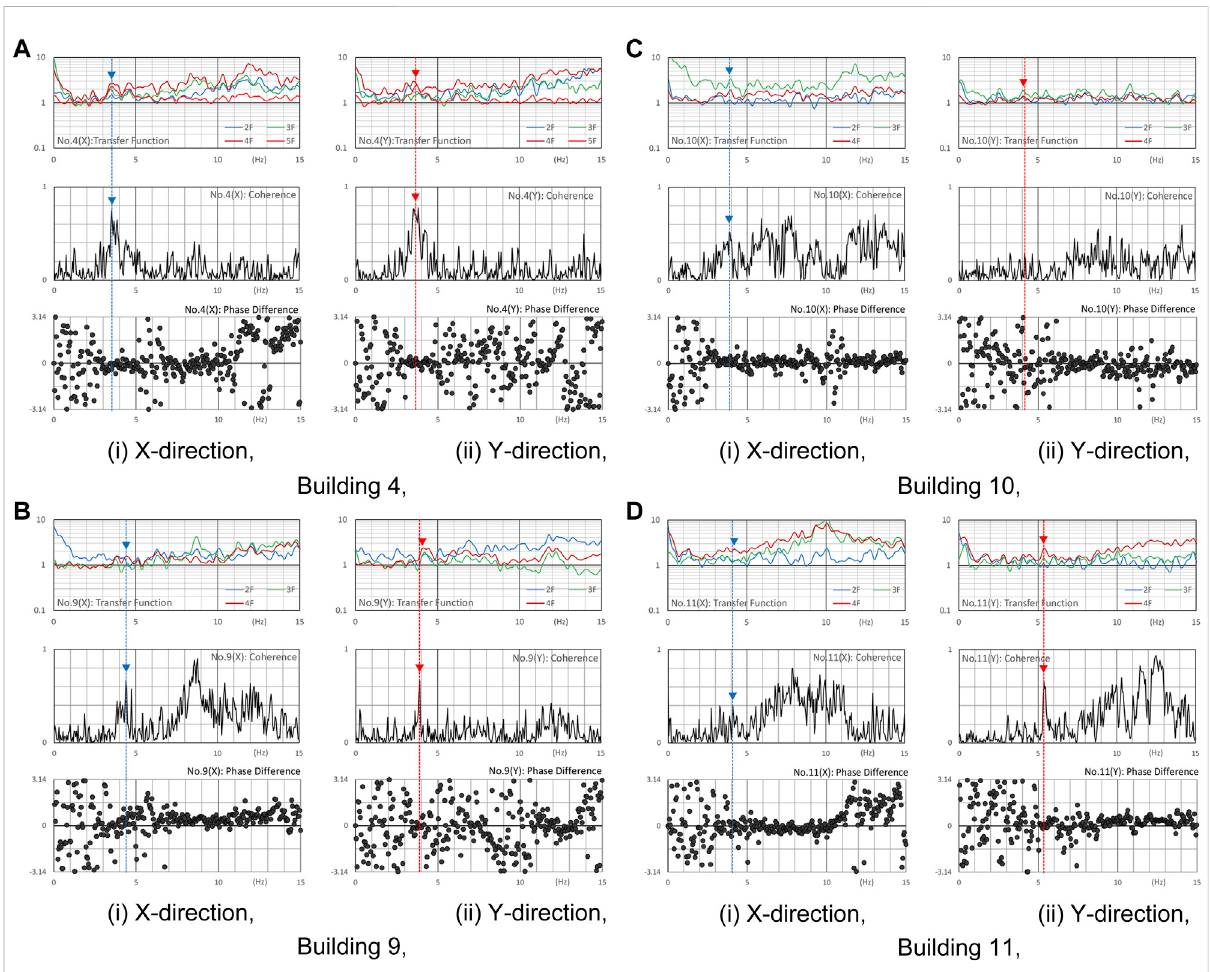
FIGURE 9 Additional microtremor measurement results. (upper row: MATF, middle row: coherence, and bottom row: phase difference.). (A) Building 4, (i) X-direction, (ii) Y-direction. (B) Building 9, (i) X-direction, (ii) Y-direction. (C) Building 10, (i) X-direction, (ii) Y-direction. (D) Building 11, (i) X-direction, (ii)